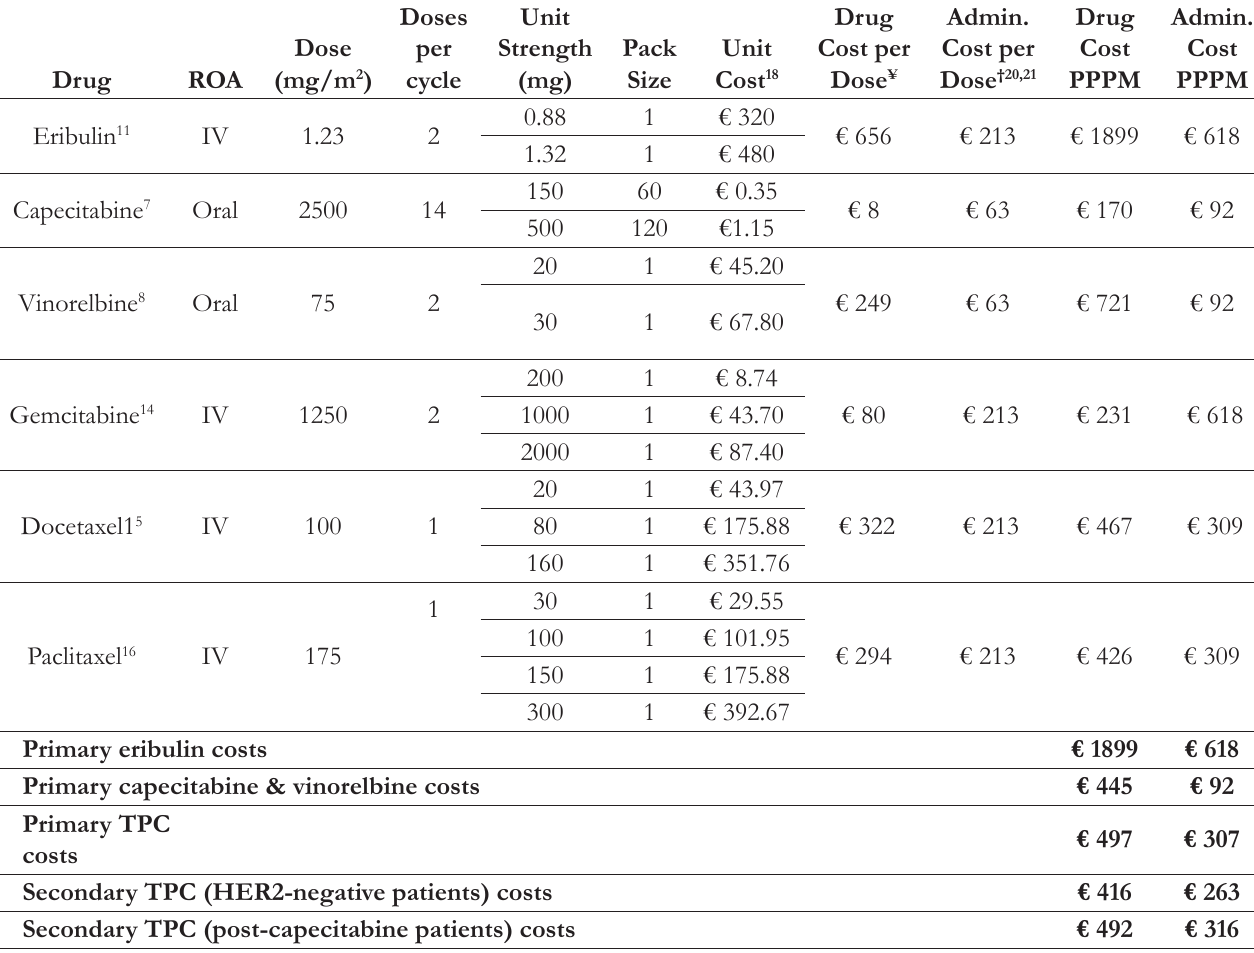
Table 1. Dosing Information and Average Costs for Chemotherapies